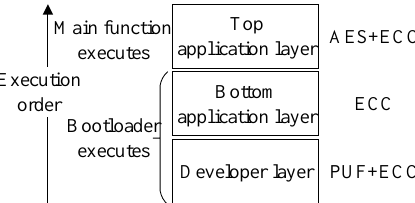
Figure 6. Triple-hybrid encryption system structure.